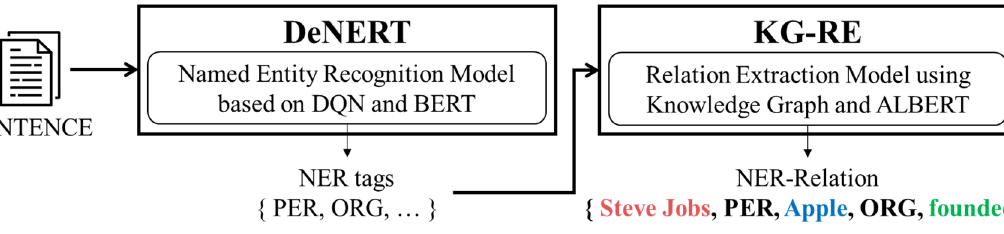
Figure 2. The overall architecture of DeNERT-KG.